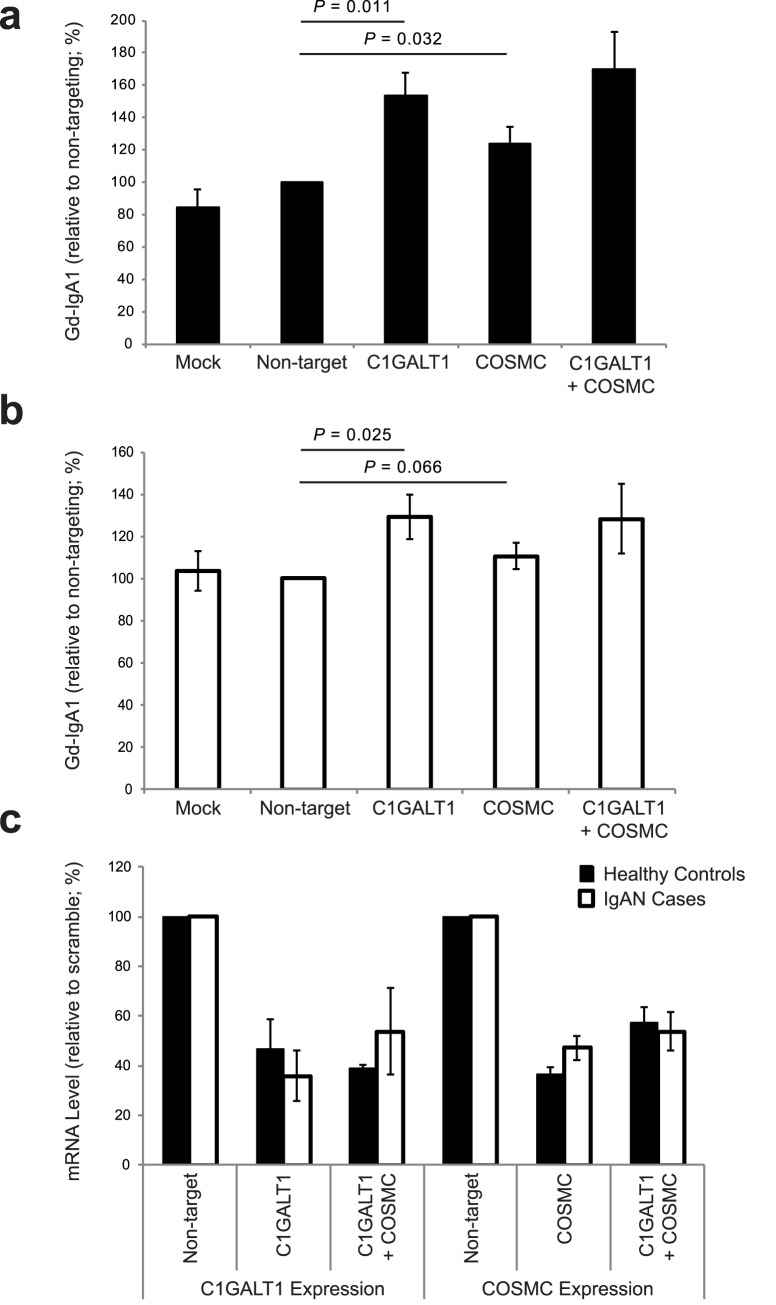
siRNA knock-down of C1GALT1, COSMC and COSMC+C1GALT1 in IgA1-secreting cell lines increases Gd-IgA1 production.(a) knock-down in IgA1-secreting cell lines from healthy controls; mock-control (n = 5), non-targeting siRNA (n = 7), C1GALT1 siRNA (n = 5), COSMC siRNA (n = 7), and COSMC+C1GALT1 siRNA (n = 2); (b) knock-down in IgA1-secreting cell lines from IgAN patients; mock-control (n = 5), non-targeting siRNA (n = 7), C1GALT1 (n = 5), COSMC siRNA (n = 7), and COSMC+C1GALT1 siRNA (n = 2); (c) relative change in mRNA in IgA1-secreting cell lines after siRNA knock-down of C1GALT1 (n = 5), COSMC (n = 7), and COSMC+C1GALT1 (n = 2) compared to non-targeting siRNA control.